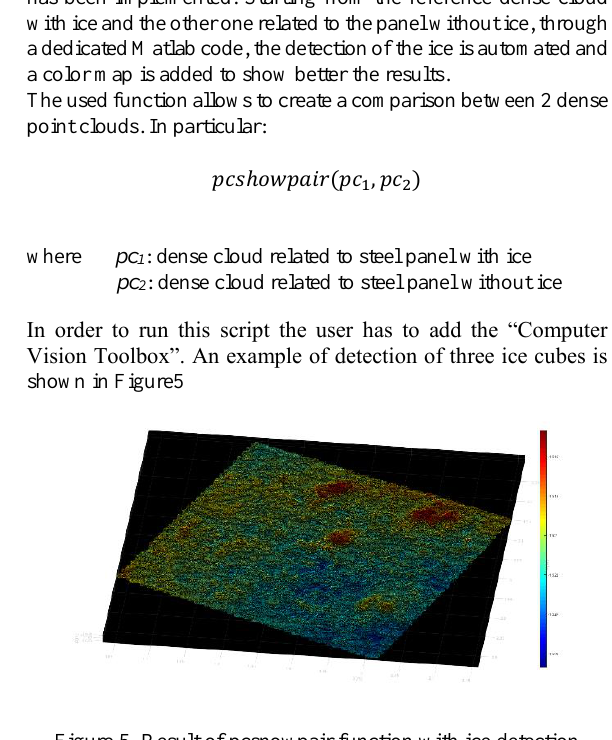
Figure 5. Result of pcsnowpair function with ice detection